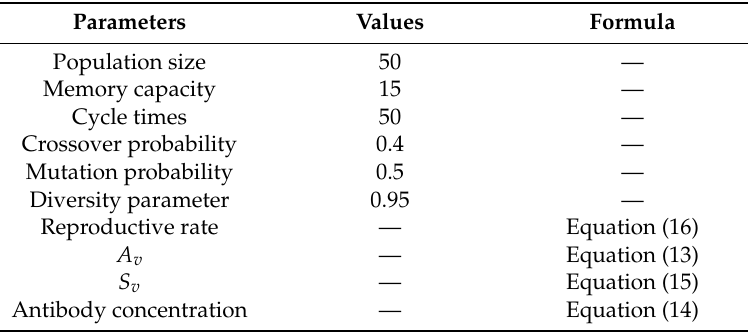
Table 3. Initialization parameters.